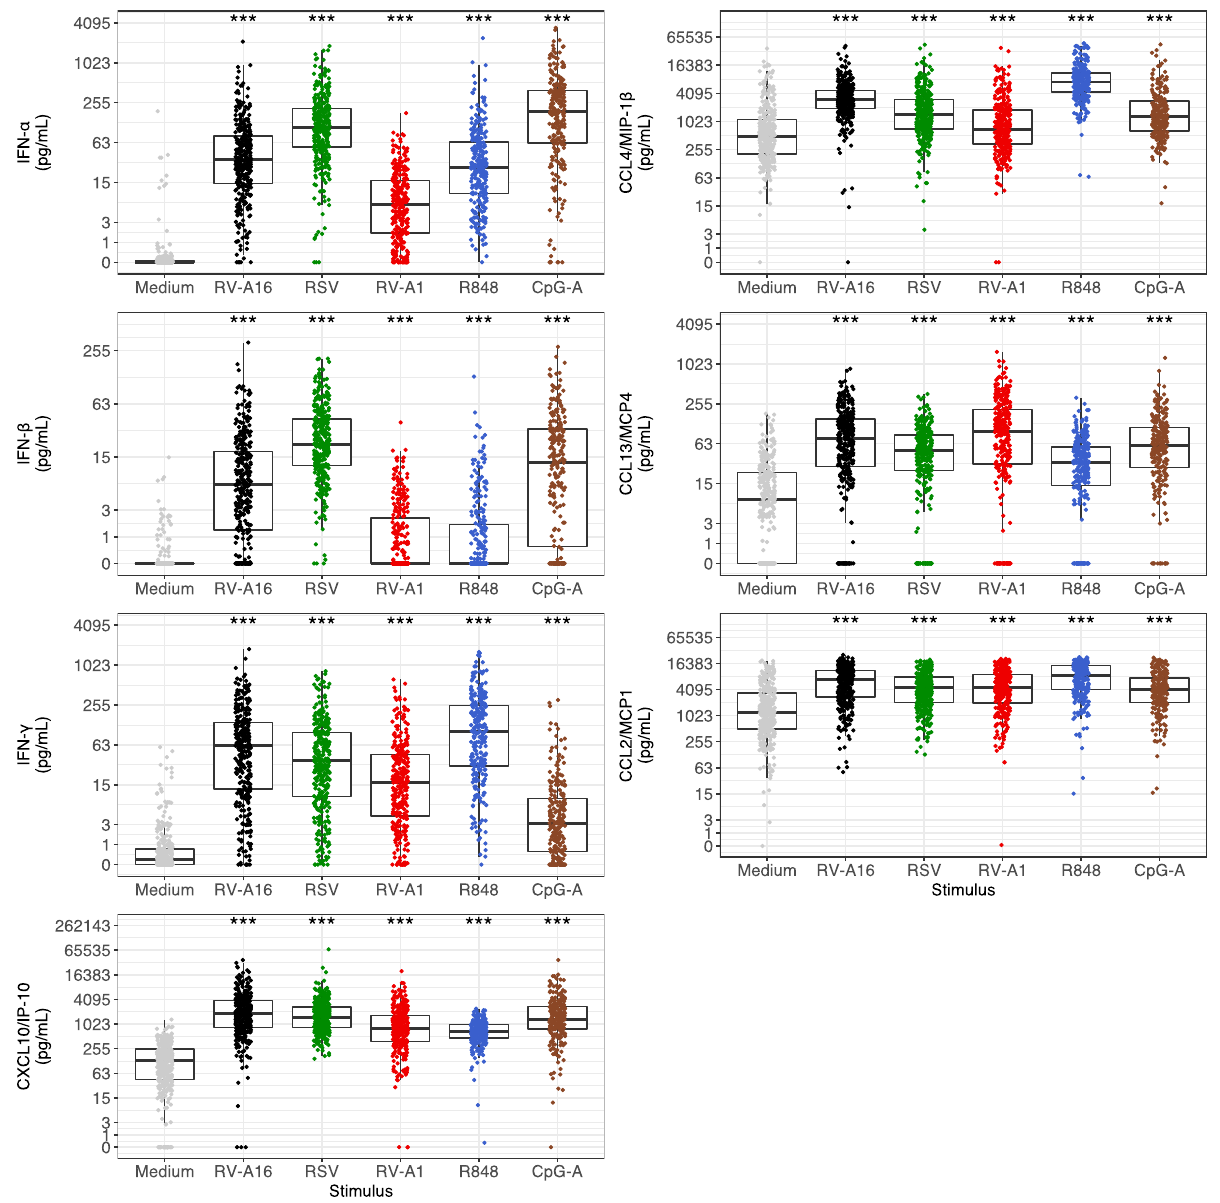
account for multiple testing. Each dot represents an individual participant. Box plots represent the 25th and 75th percentiles, the line the median, with whiskers at the 10th and 90th percentiles. Data are presented in pg/mL. The y axis is plotted on a logarithmic scale. Significance levels: *** P < 0.001 compared to